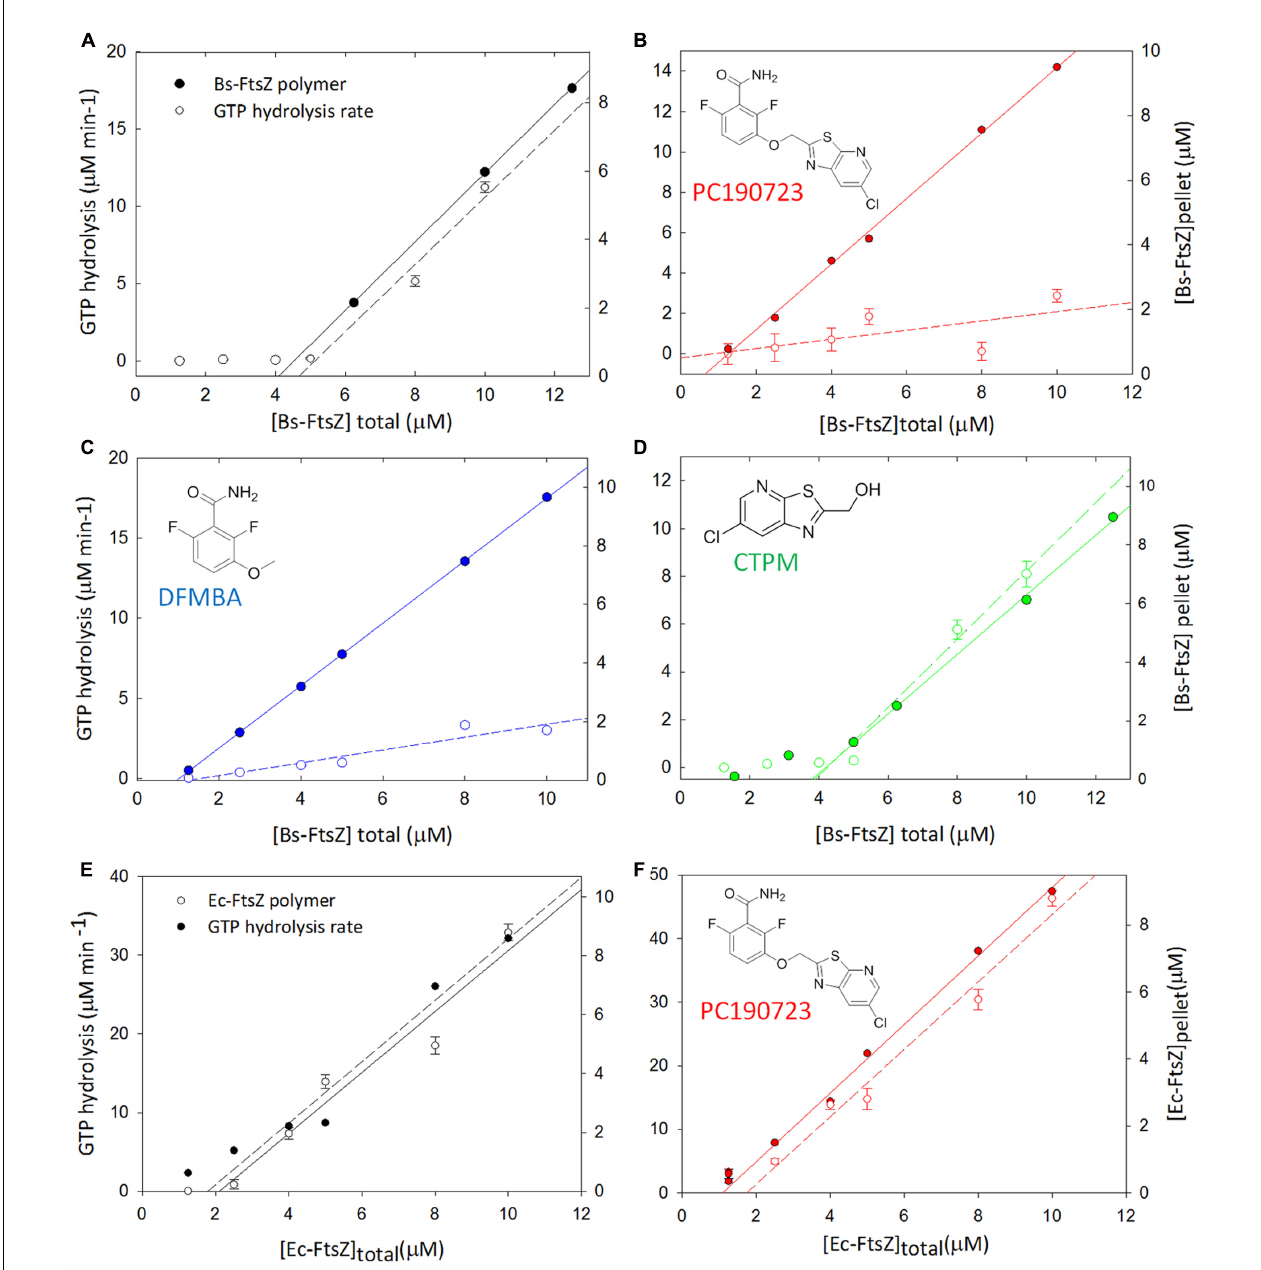
FIGURE 3 | Effect of PC190723 and its fragments on assembly and GTPase activity of BsFtsZ and EcFtsZ. (A − D) Graphs showing the relationship between the sedimentation of BsFtsZ polymers and the rate of hydrolysis in the presence of GTP (2 mM) and no compound (A) or presence of PC190723 15 µ M (B) , DFMBA 4 mM (C) , and CTMP 1 mM (D) . E-F experiments with EcFtsZ showing the correlation of GTPase activity with polymer concentration in the presence of GTP (2 mM) and the absence of compound (E) or presence of 15 µ M PC190723 (F) . For Cr and GTPase activity values see Supplementary Table